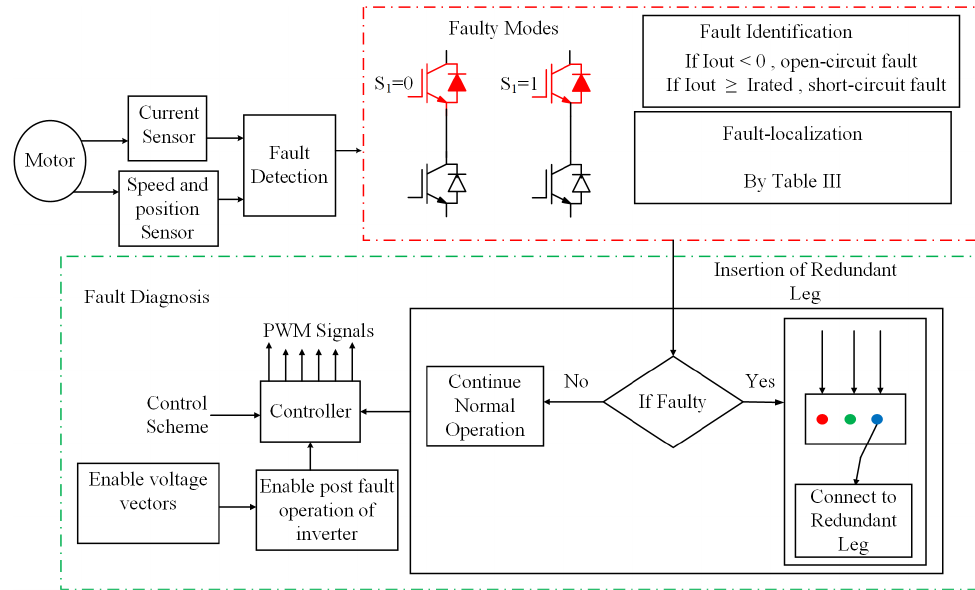
Figure 8. Schematic structure of the proposed fault-tolerant